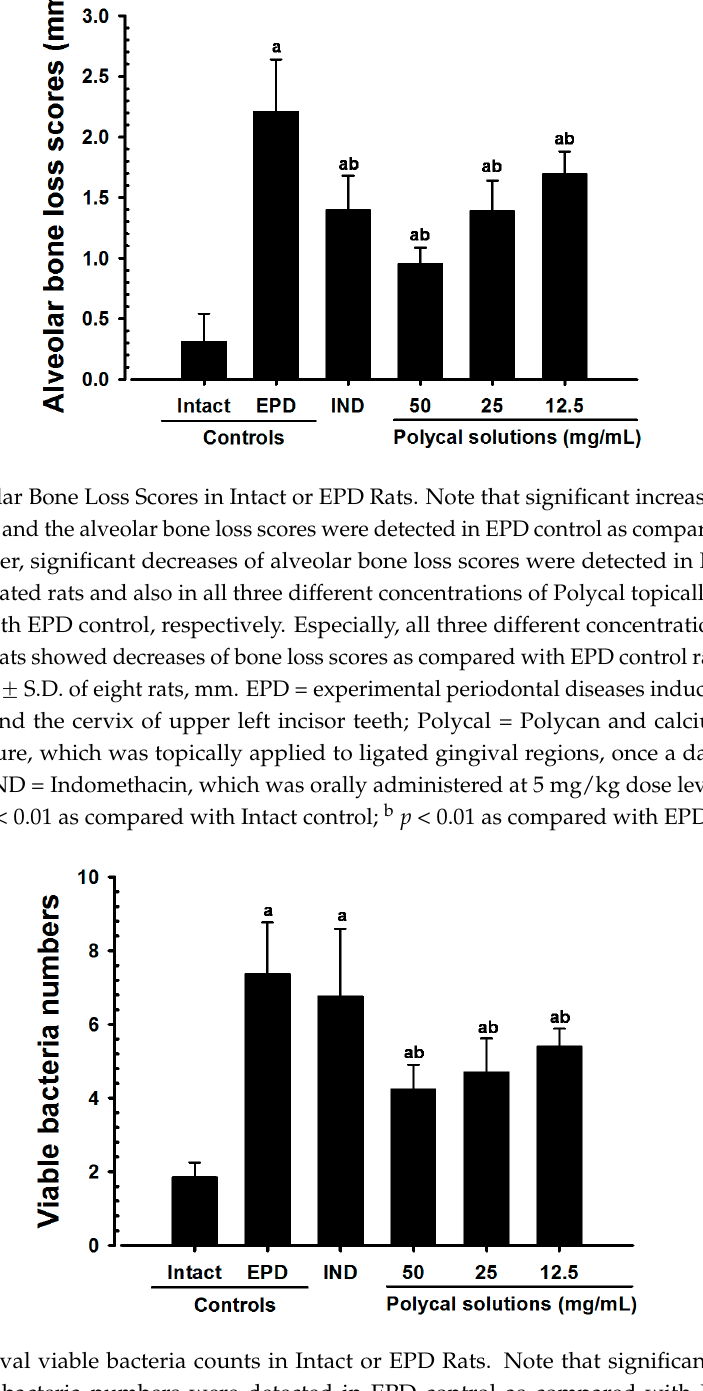
Figure 3. Gingival viable bacteria counts in Intact or EPD Rats. Note that significant increases of gingival viable bacteria numbers were detected in EPD control as compared with Intact control. However, significant decreases of viable bacteria numbers were detected in all three different concentrations of Polycal topical applied rats as compared with EPD control, respectively. Anyway, no meaningful changes on the viable bacteria numbers were demonstrated in IND 5 mg/kg oral administered rats as compared with EPD control, in this result. Values are expressed mean ± S.D. of eight rats, Log CFU × 10 5 /g tissue. EPD = experimental periodontal diseases induced by ligature placement around the cervix of upper left incisor teeth; Polycal = Polycan and calcium gluconate 2:98 (g/g) mixture, which was topically applied to ligated gingival regions, once a day for 10 days (200 μ L/rats); IND = Indomethacin, which was orally administered at 5 mg/kg dose level, once a day for 10 days. a p < 0.01 as compared with Intact control; b p < 0.01 as compared with EPD control.